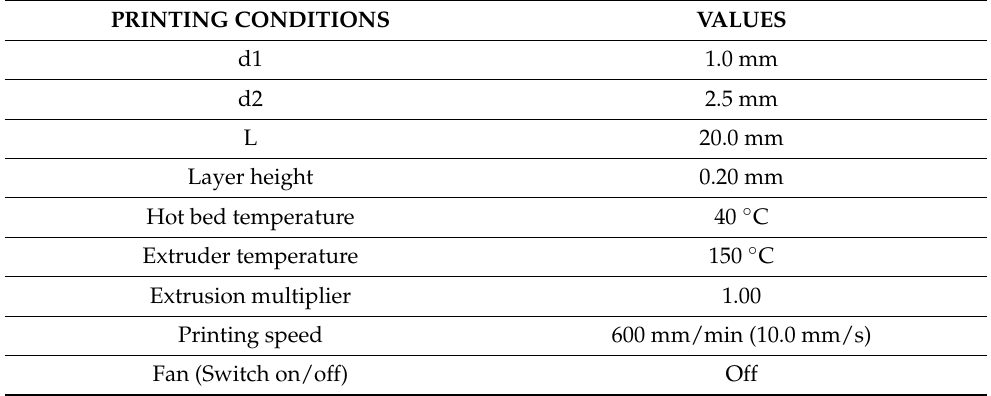
Table 2. Reference values used as a model base for the study to generate rectilinear patterns with